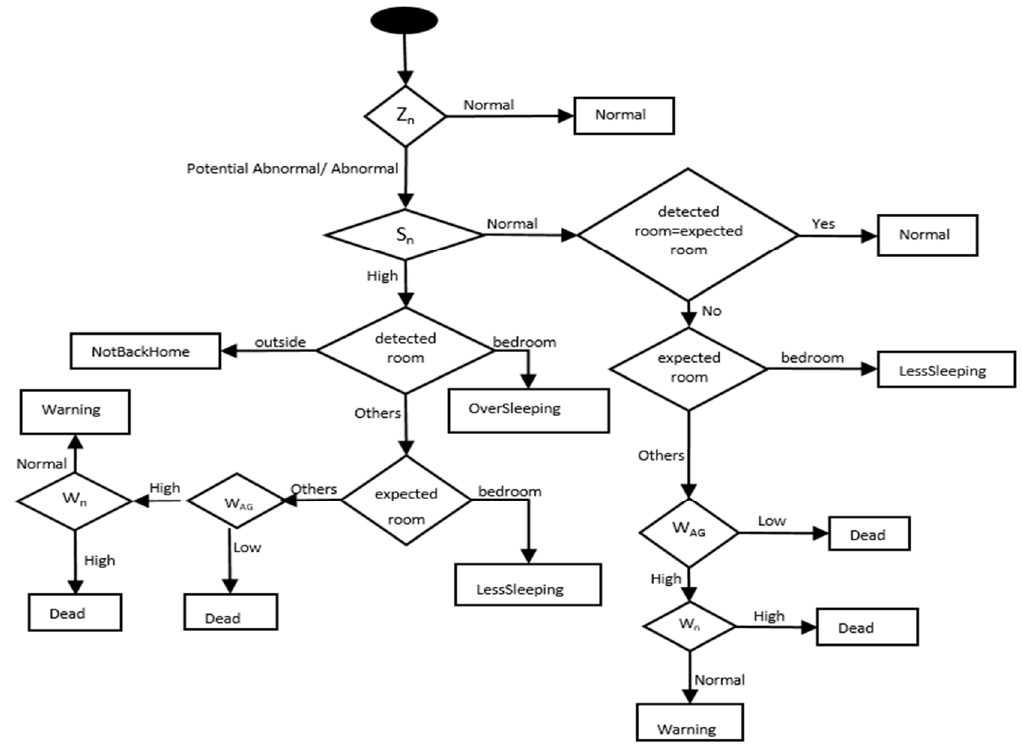
Figure 6. Rule-based Anomaly Classification.